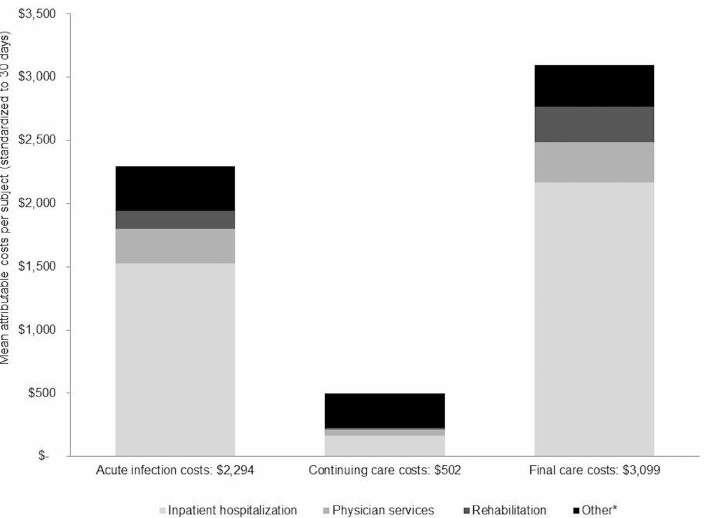
Fig 2. Stratification of phase-specific costs by healthcare services. * Other- Includessame day surgery, ED visits, outpatientmedication, non-physician services, outpatient laboratorytests, complexcontinuingcare, home care services, long-term care, dialysisclinic visits, cancer clinic visits, and assisted devices.